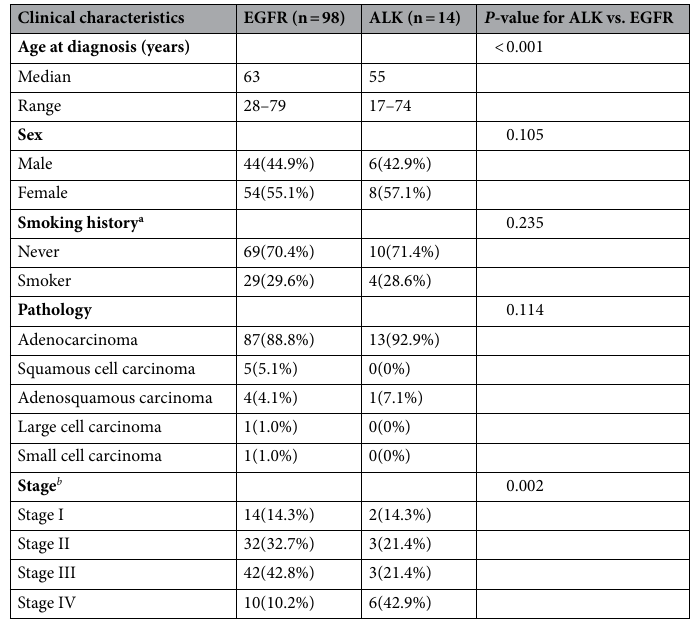
Table 3. The clinicopathologic characteristics of EGFR and ALK-positive patients with lung cancer. a Never smokers have smoked less than 100 cigarettes per lifetime. Smokers have smoked more than 100 cigarettes (current or former). b Clinical stage represents stage at initial diagnosis. Stage was determined according to WHO TNM classification of lung carcinomas in 2015.